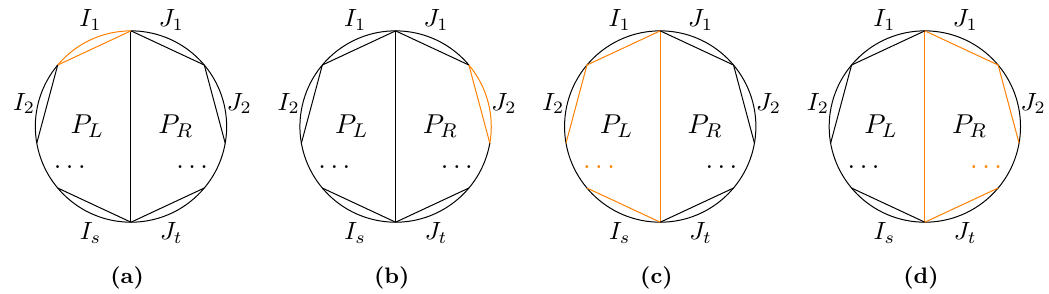
Figure 7. An illustrative figure for showing the equivalence between different cutting out processes. The position of the “final block” is indicated by